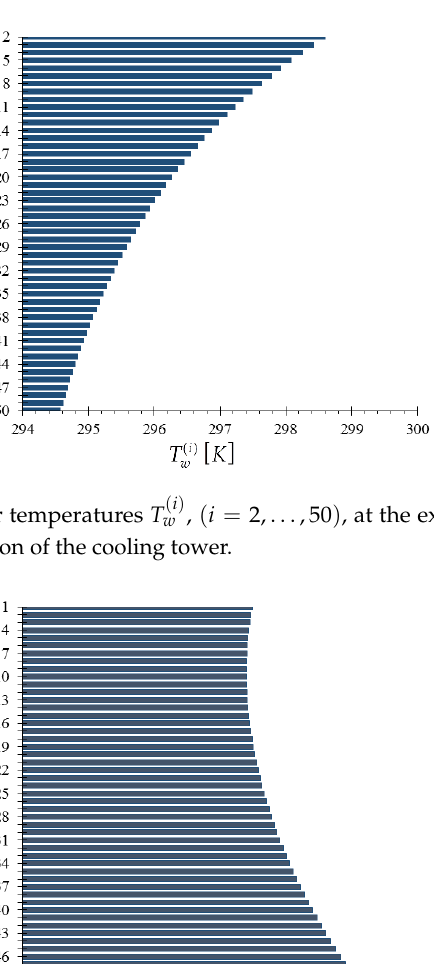
Figure 4. Bar plot of the water mass flow rates m ( ) i along the height of the fill section of the cooling tower.